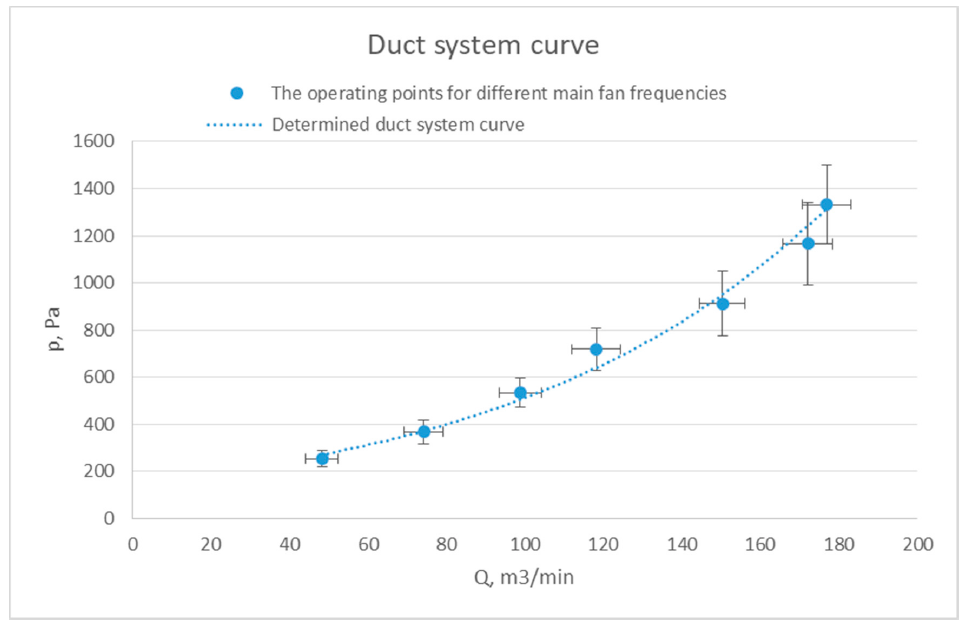
Figure 8. Determined system curve of the utilised NPPS installation.